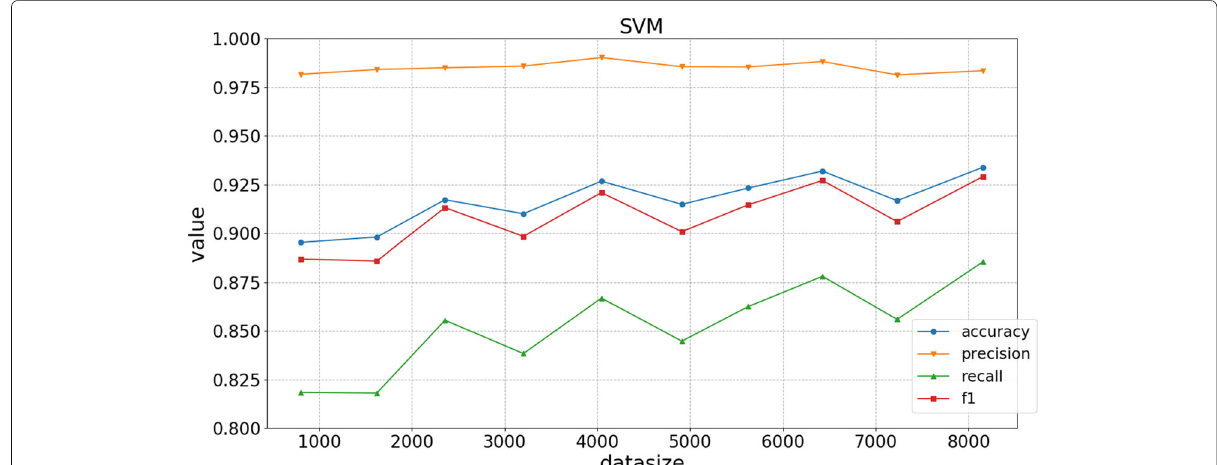
Fig. 11 Result of SVM with different training set size. We test the SVM classifier using subsets with the following sizes: 803, 1622, 2357, 3201, 4043, 4909, 5628, 6425, 7230, and 8155, where the ratio of positive/negative is close to 1. The accuracy is high, which is above 95%. With the increase of data size, the results get better